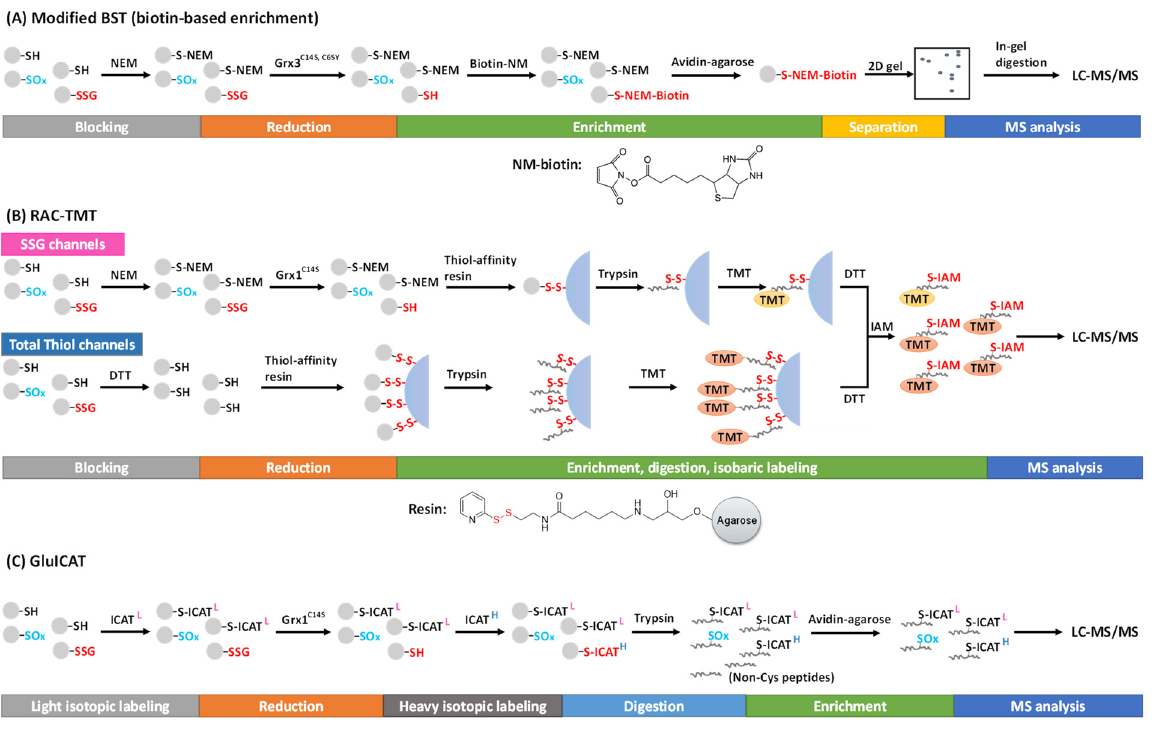
Figure 4. Proteomic approaches for SSG detection and quantification using the selective reduction and tagging strategy. ( A ) Modified BST, ( B ) RAC-TMT. and ( C ) GluICAT approches